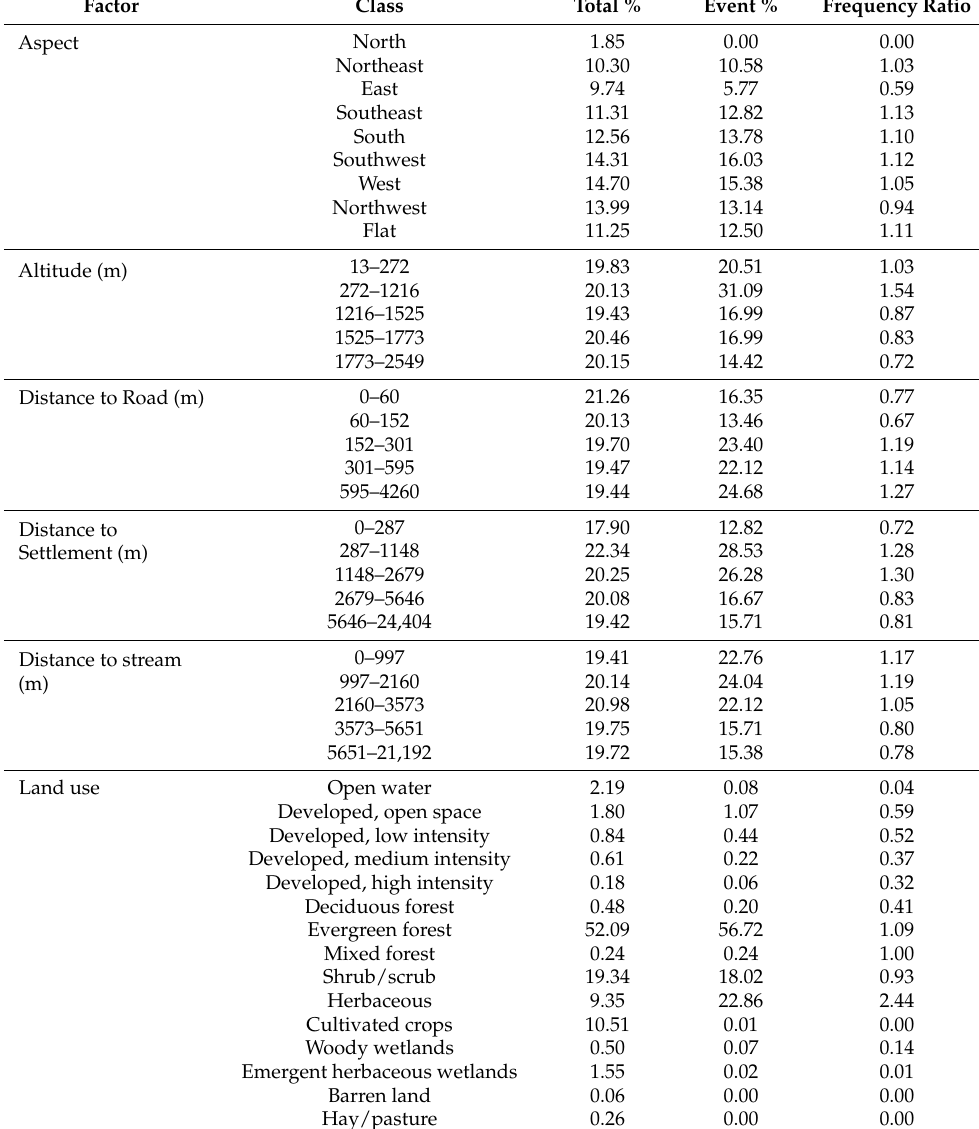
Table 5. Frequency ratio of wildfire conditioning